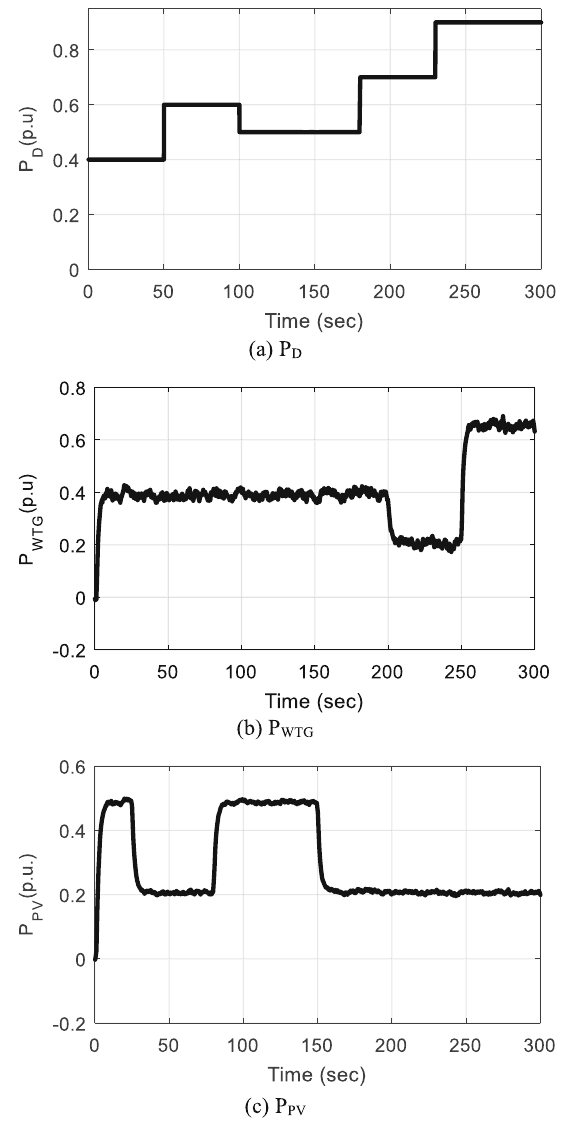
Fig. 9 Independent load/sources a P D b P WTG c P PV